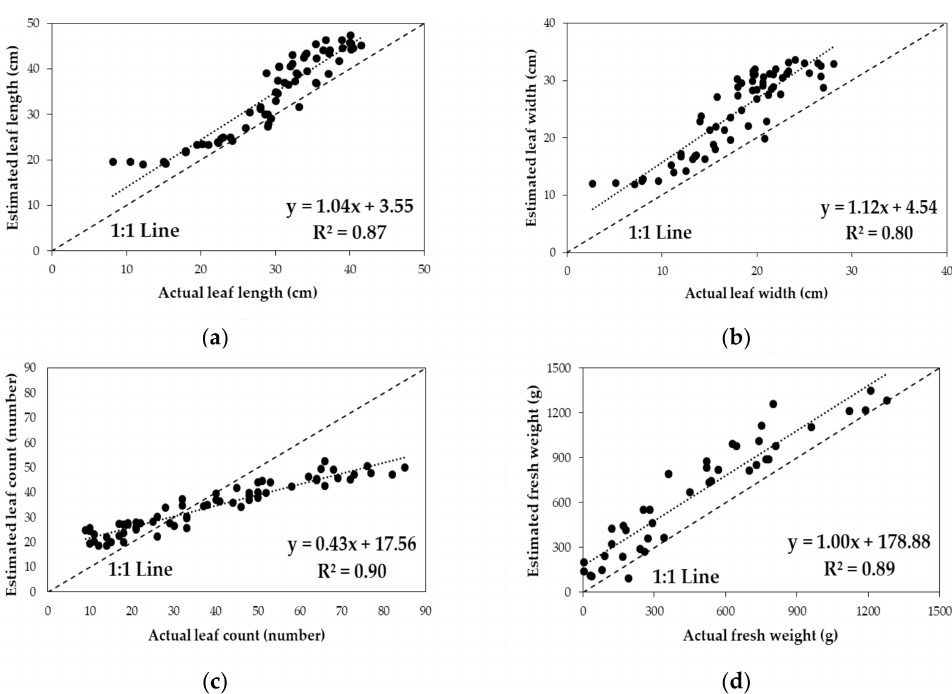
Figure 12. Relationships of biophysical properties (( a ) leaf length; ( b ) leaf width; ( c ) leaf count; and ( d ) fresh weight) of Chinese cabbage determined by the derived unmanned aerial vehicle (UAV)-estimated models and by standard methods.